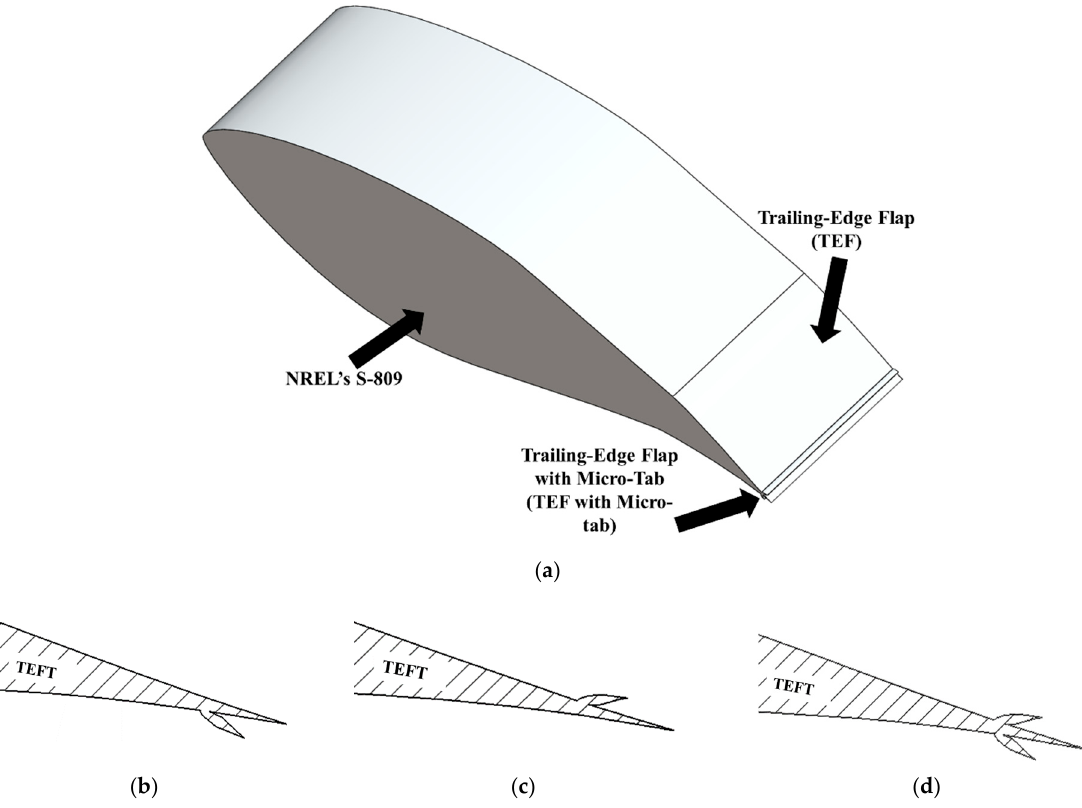
Figure 3. The geometry of TEF with Micro-Tab positions: ( a ) 3D front view, ( b ) Pattern 1 with lower Micro-Tab, ( c ) Pattern 2 with upper Micro-Tab, ( d ) Pattern 3 with upper and lower Micro-Tabs.